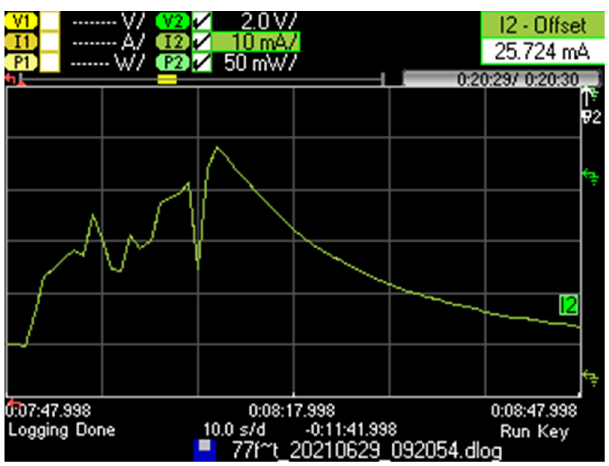
Figure 5. Current consumption pattern of a RockBLOCK Mk2 device that is initially in sleep state, performs an unsuccessful message transmission attempt, and returns to sleep state.